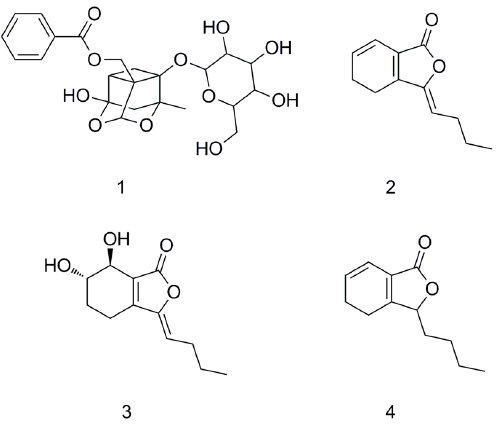
Figure 1. Chemical structure of paeoniflorin ( 1 ), ligustilide ( 2 ), senkyunolide I ( 3 ) and senkyunolide A ( 4 ).